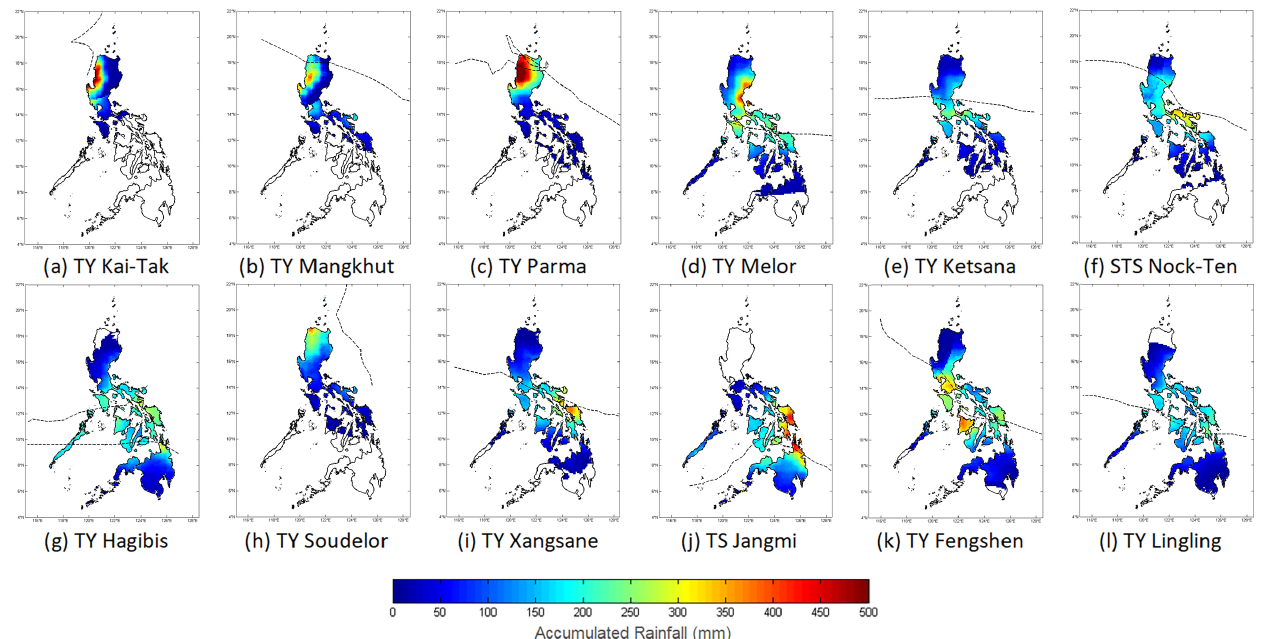
Figure 8. Rainfall distribution of selected composite rain forecast of TC events using GSMaP_G and TC track (as in Figure 2) of the following TCs: ( a ) TY Kai-Tak (0004), ( b ) TY Mangkhut (1822), ( c ) TY Parma (0917), ( d ) TY Melor (1527), ( e ) TY Ketsana (0916), ( f ) STS Nock-Ten (1108), ( g ) TY Hagibis (0724), ( h ) TY Soudelor (0306), ( i ) TY Xangsane (0615), ( j ) TS Jangmi (1423), ( k ) TY Fengshen (0806), and ( l ) TY Lingling (0123).